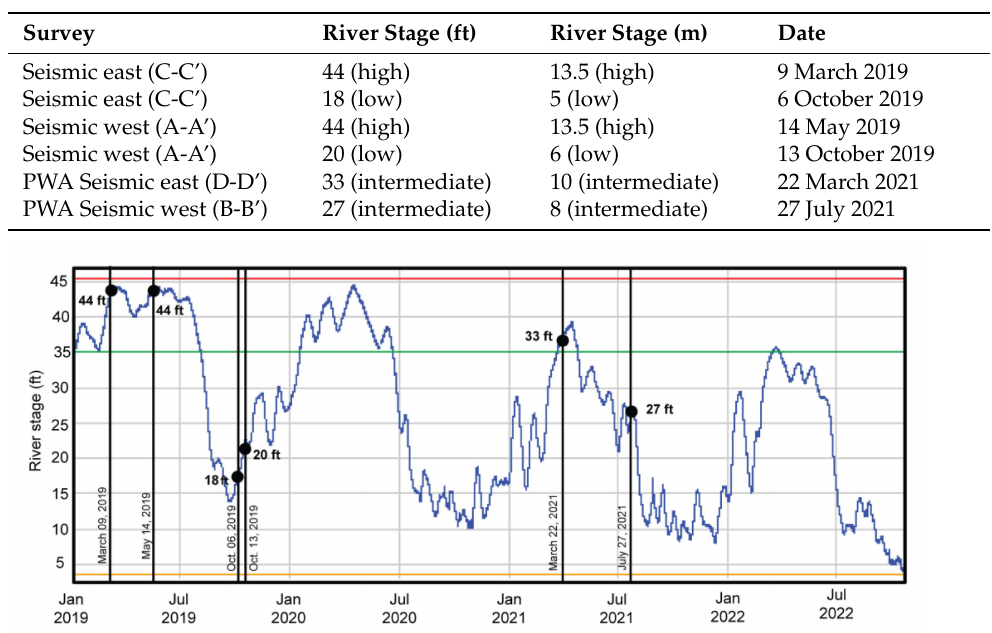
Table 2. Acquisition survey dates with their respective river stages.